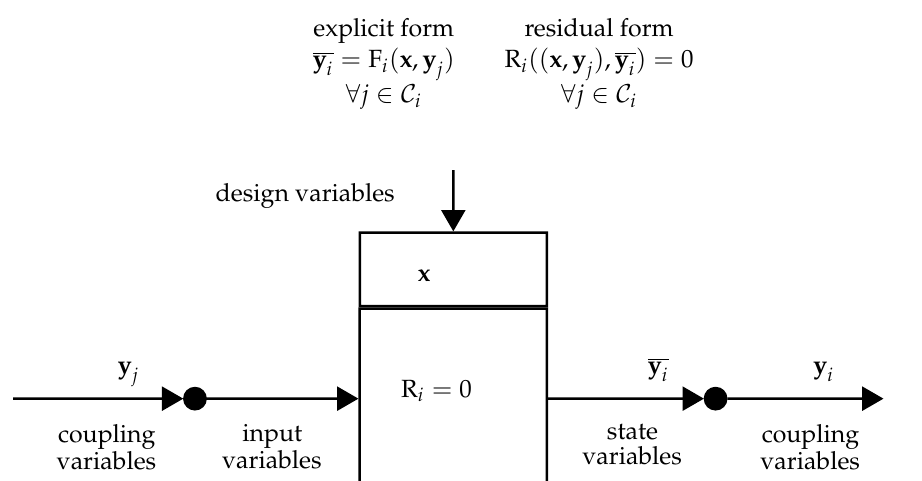
Figure 5. A contributing analysis ( i ) modelled in detail, receiving input from another CA ( j